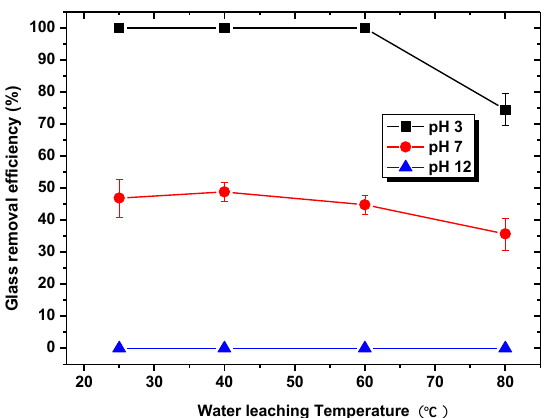
Figure 8. Effect of water leaching temperature on glass removal efficiency (experimental conditions: abrasive – glass polishing waste: approximately 1 g; roasting temperature: 450 °C; mass ratio of polishing waste to NaOH: 1:1; roasting time: 30 min; liquid – solid ratio: 200 mL/g).